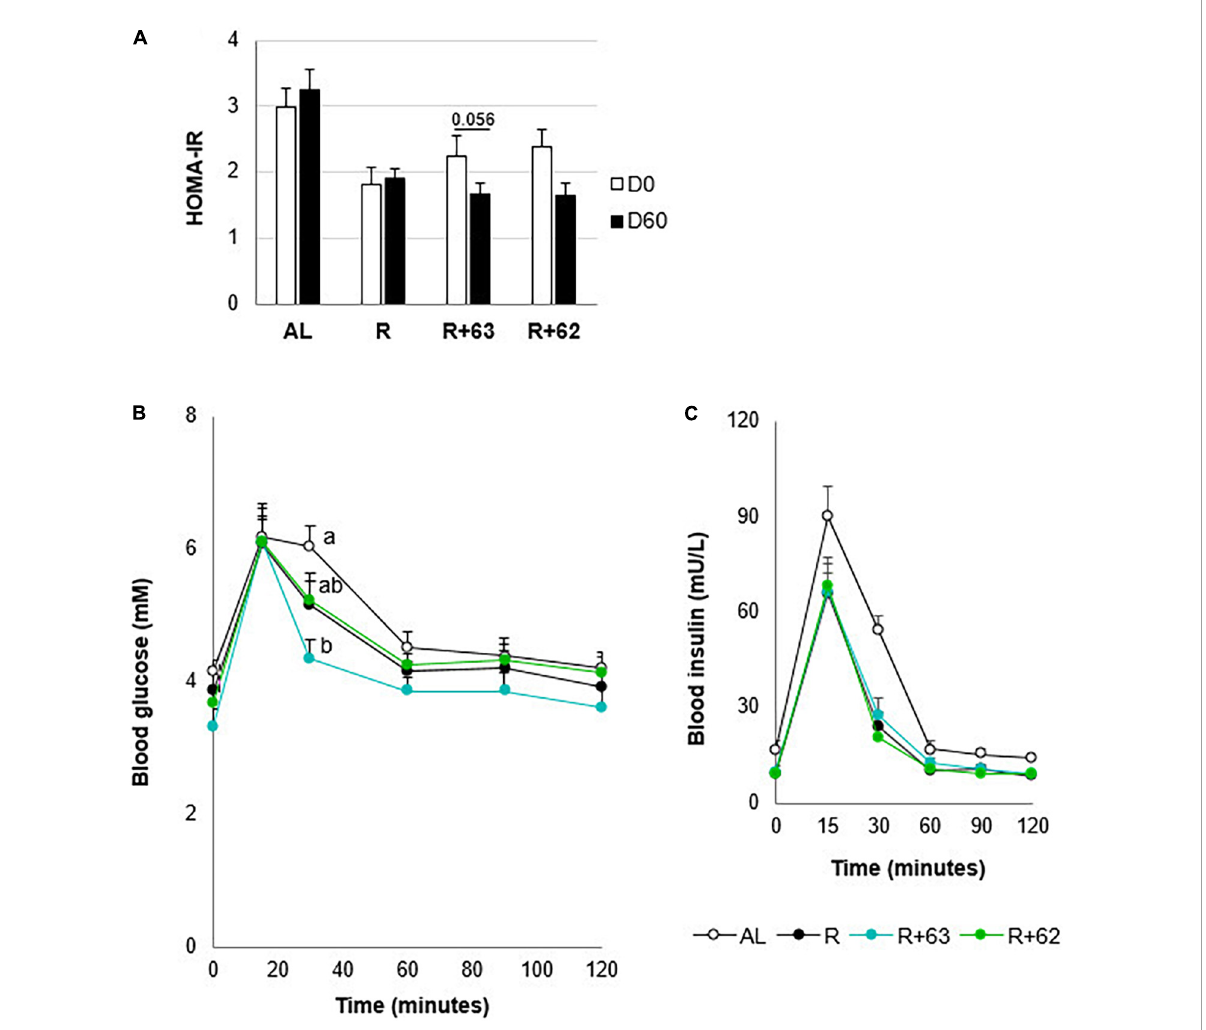
FIGURE5 Insulin resistance and glucose tolerance in 18-month-old rats fed an ad libitum (AL) diet or a food-restricted (R) diet over a 2-month period; two food-restricted groups received a probiotic supplement – either strain 62 (R+62) or strain 63 (R+63). (A) Insulin resistance at the start (day 0) and end (day 60) of the experiment. (B) Plasma glucose levels measured during the oral glucose tolerance test on day 60. (C) Plasma insulin levels during the oral glucose tolerance test on day 60. Values are means ± SEM. Differences in letters indicate a significant difference between groups (ANOVA and Tukey post hoc tests, p ≤ 0.05, n = 54